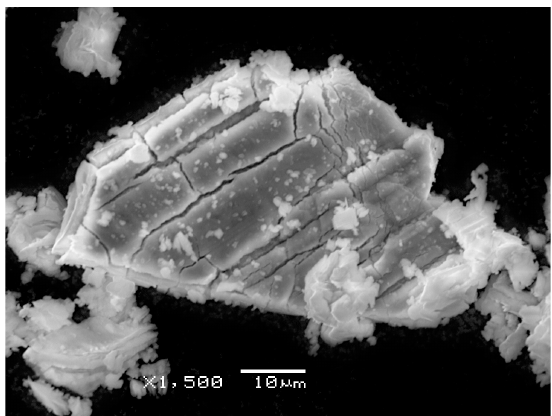
Figure 6. SEM morphology of a grain of the sample S1 after thermal process at 1150 ◦ C (1423